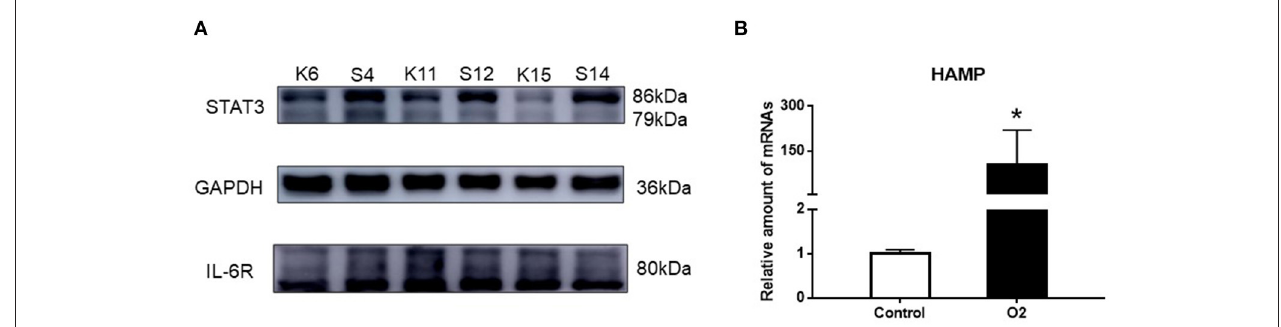
FIGURE 3 | The expression of STAT3, IL-6R, and HAMP mRNA. (A) Western blot result showing the expression of STAT3 and IL-6R in the hyperoxia and air groups. (B) PCR result showing the expression of HAMP mRNA in the hyperoxia and air groups. Air group: K6, K11, K15; Hyperoxia group: S4, S12, S14 (* p < 0.05).